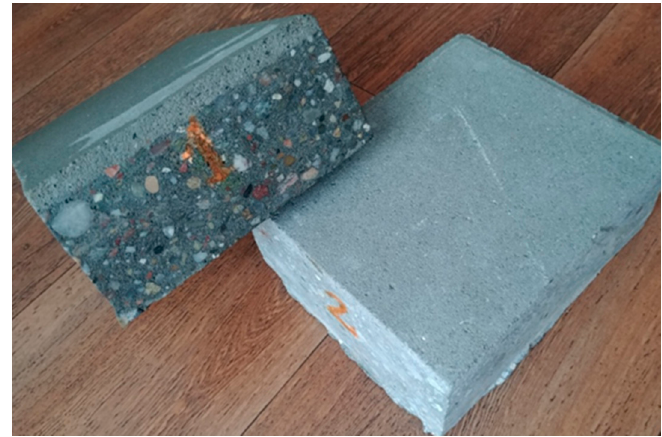
Figure 1. Photocatalytic concrete paving block studied in the research with a novel test method.